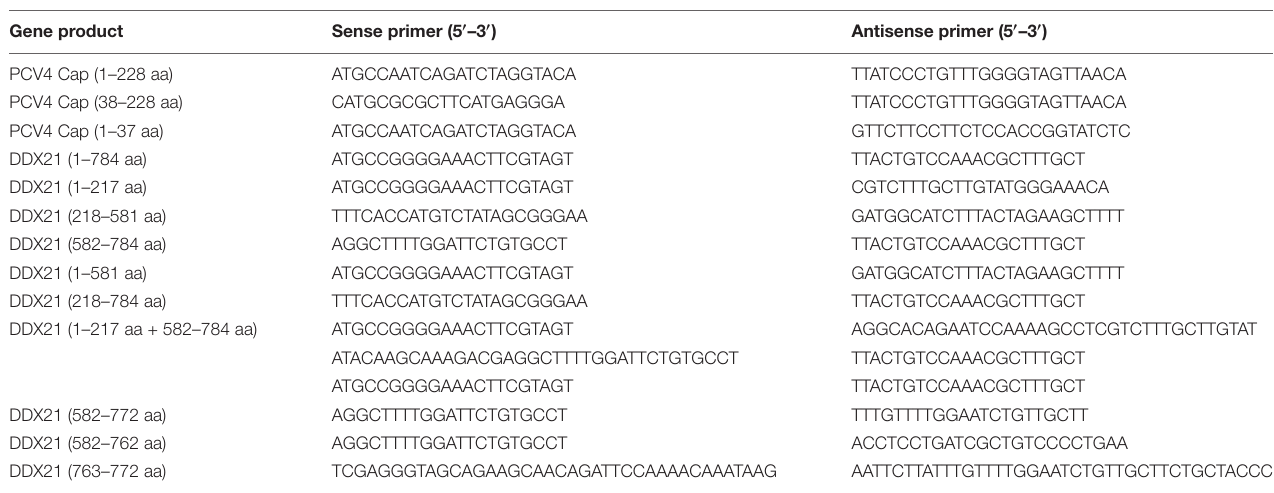
TABLE 2 | List of primers adopted in the study. Gene